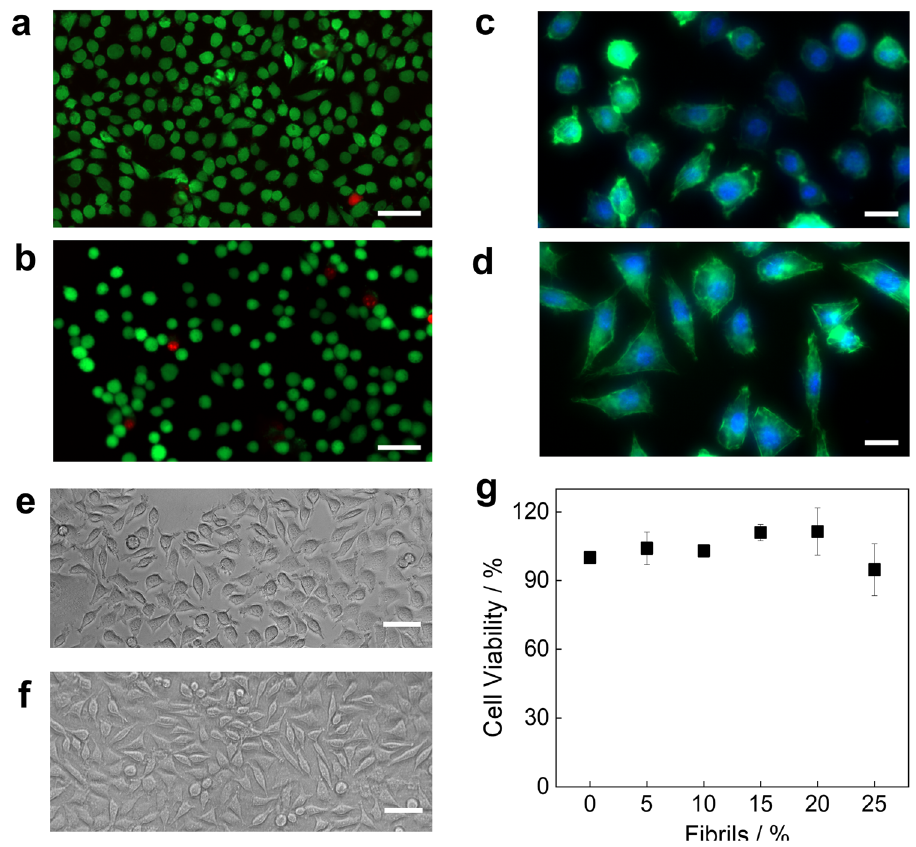
Fig. 7 Cytocompatibility assays of protein fi brils. Live-Dead assay of a control cells and b in presence of 25% of protein fi brils (scale bar: 50 μ m). Green channel: live cells – Calcein – AM, Red channel: necrotic cells – PI. Fluorescent micrographs of the morphology of c control cells and d cells incubated with 25% of protein fi brils (scale bar: 20 µ m). Green channel: F-actin – fl uorescein phalloidin, Blue channel: nucleus – DAPI. Optical micrographs of e control cells with no fi brils and f with cells incubated with 25% of the EWP fi brils stock solution (scale bar: 50 µ m). g Viability plot of L929 cells in presence of different concentrations of protein fi brils (5 – 25%). Data are presented as average ± standard deviation (NS = no signi fi cant difference compared to the control (no fi